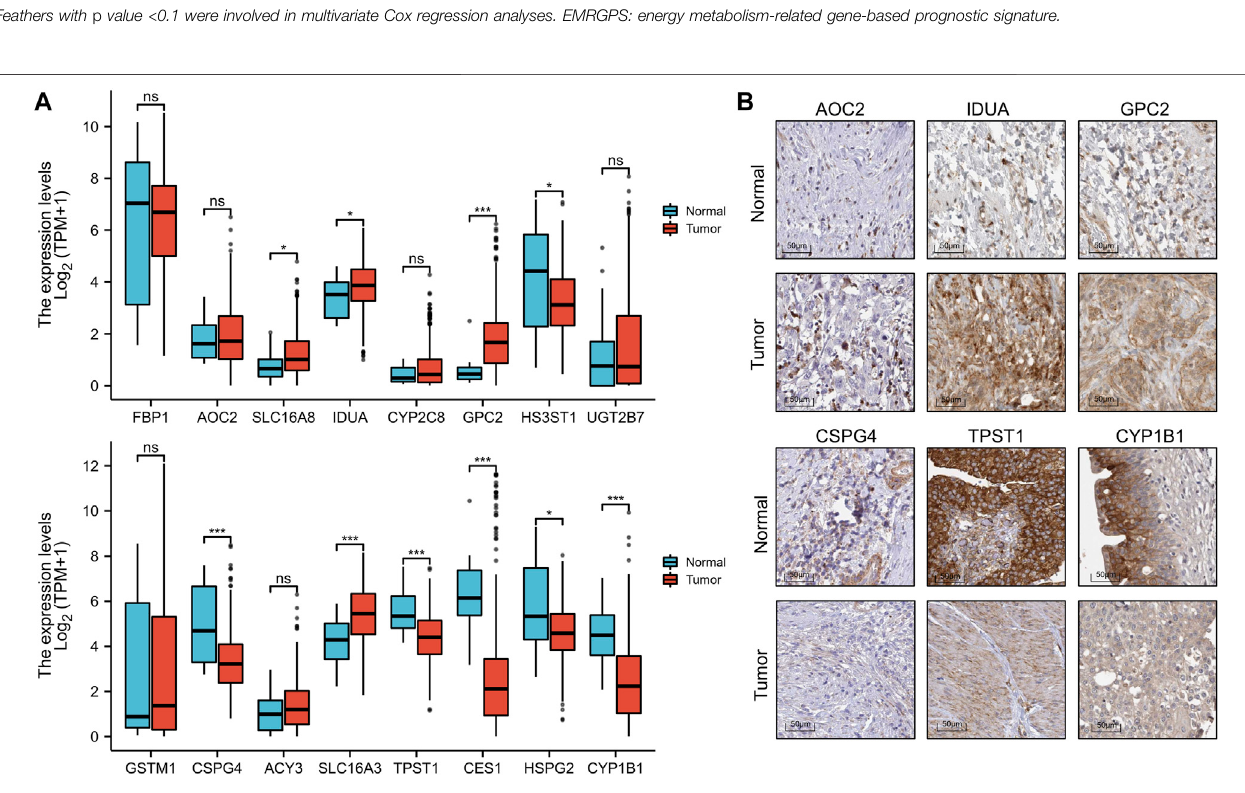
Frontiers in Cell and Developmental Biology |